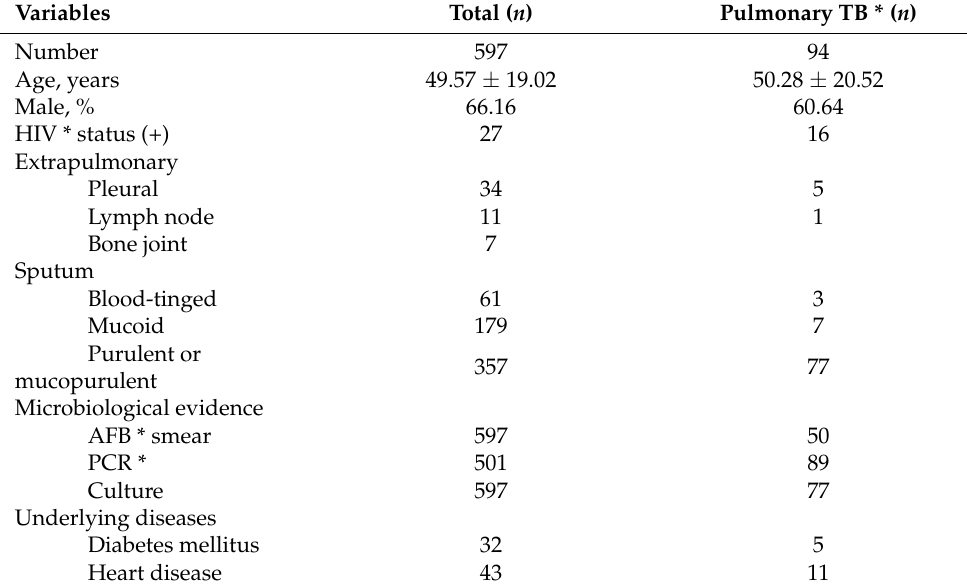
Table 1. Baseline characteristics of included patients.